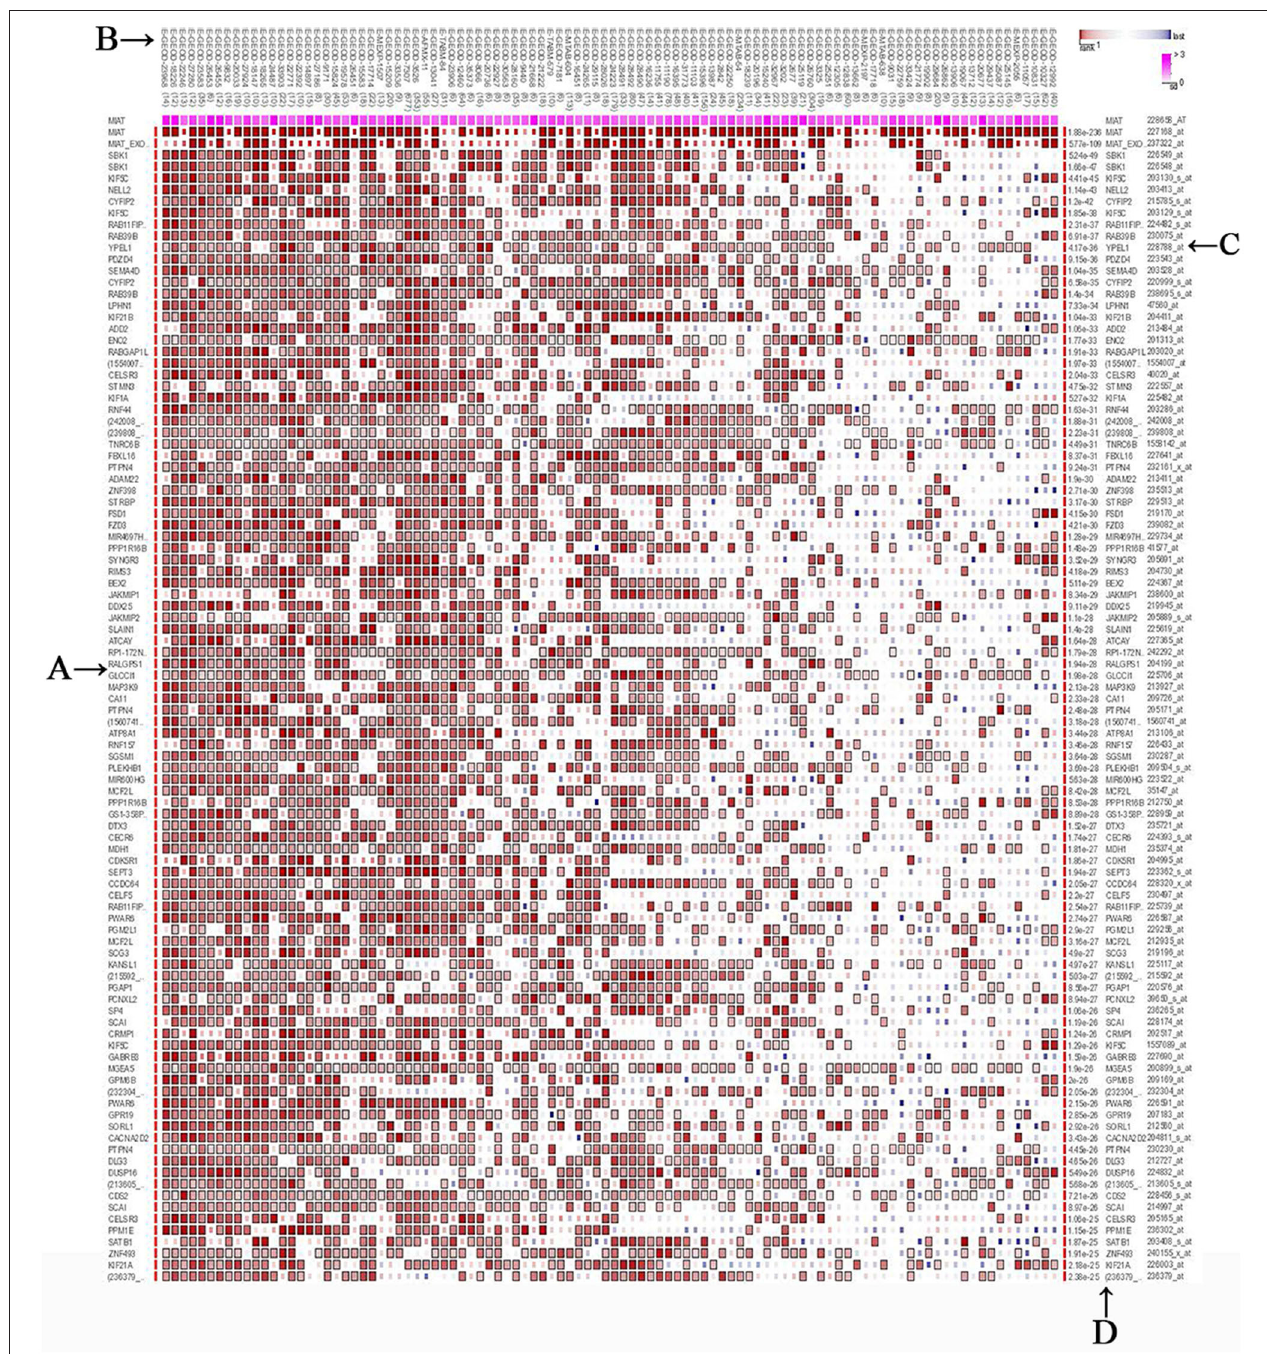
FIGURE 6 | The top 200 predicted target genes of lincRNA MIAT by using Multi Experiment Matrix (MEM, http://biit.cs.ut.ee/mem/) website. (A) Predicted target genes; (B) single experimental data set; (C) gene probes; (D) P values.